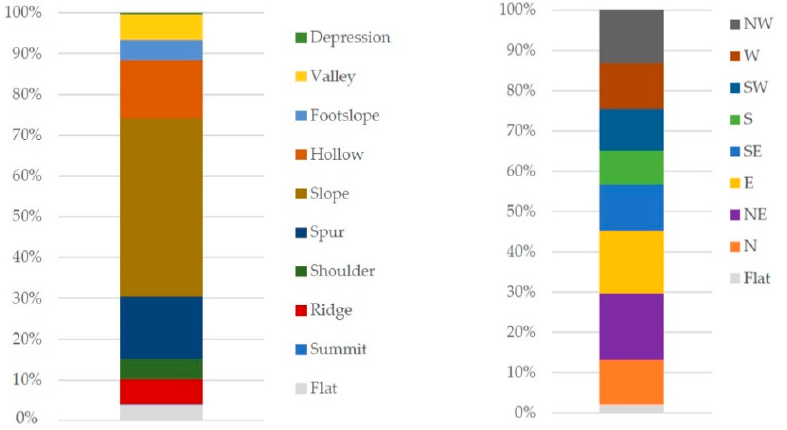
Figure 12. Frequency distribution histograms (%) for each geomorphology class (left) and for each orientation class (right).